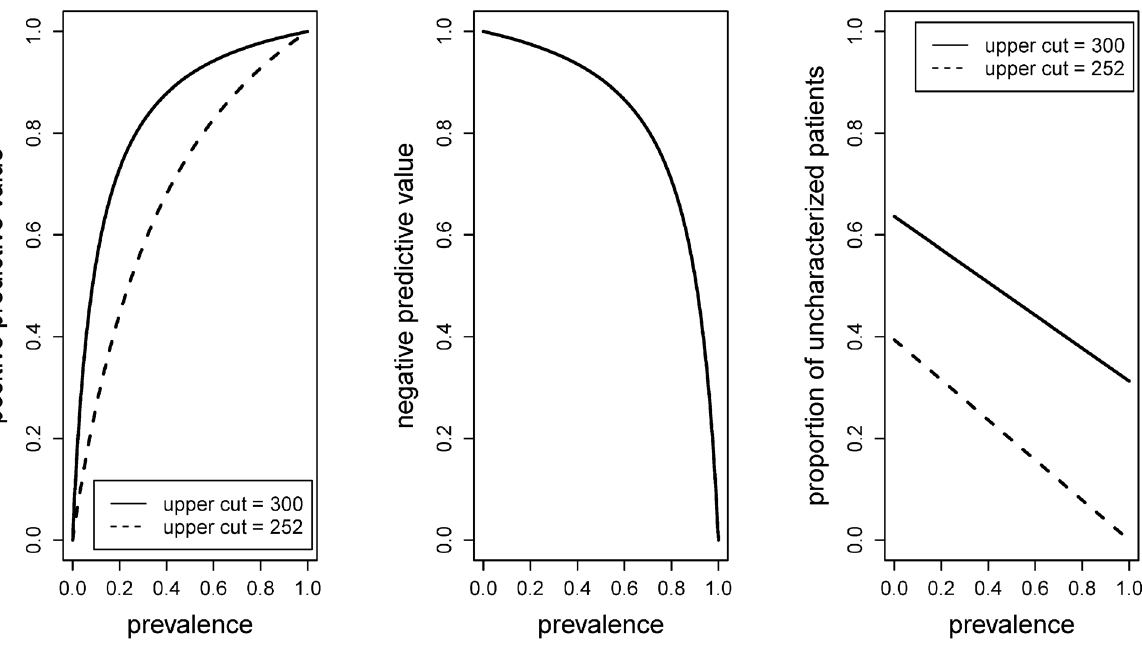
Figure 4. Positive and negative predictive values as well as proportion of uncharacterized cases as they depend upon prevalence. S0–1 patients and controls were classified as healthy and S2–3 as sick. The diagnostic procedure made use of CAP where those with values below 215 dB/m were diagnosed as healthy, those with values above 300 dB/m (or 252 dB/m, dashed lines) were diagnosed as sick and those in between were not diagnosed. A total of 61 valid measurements were